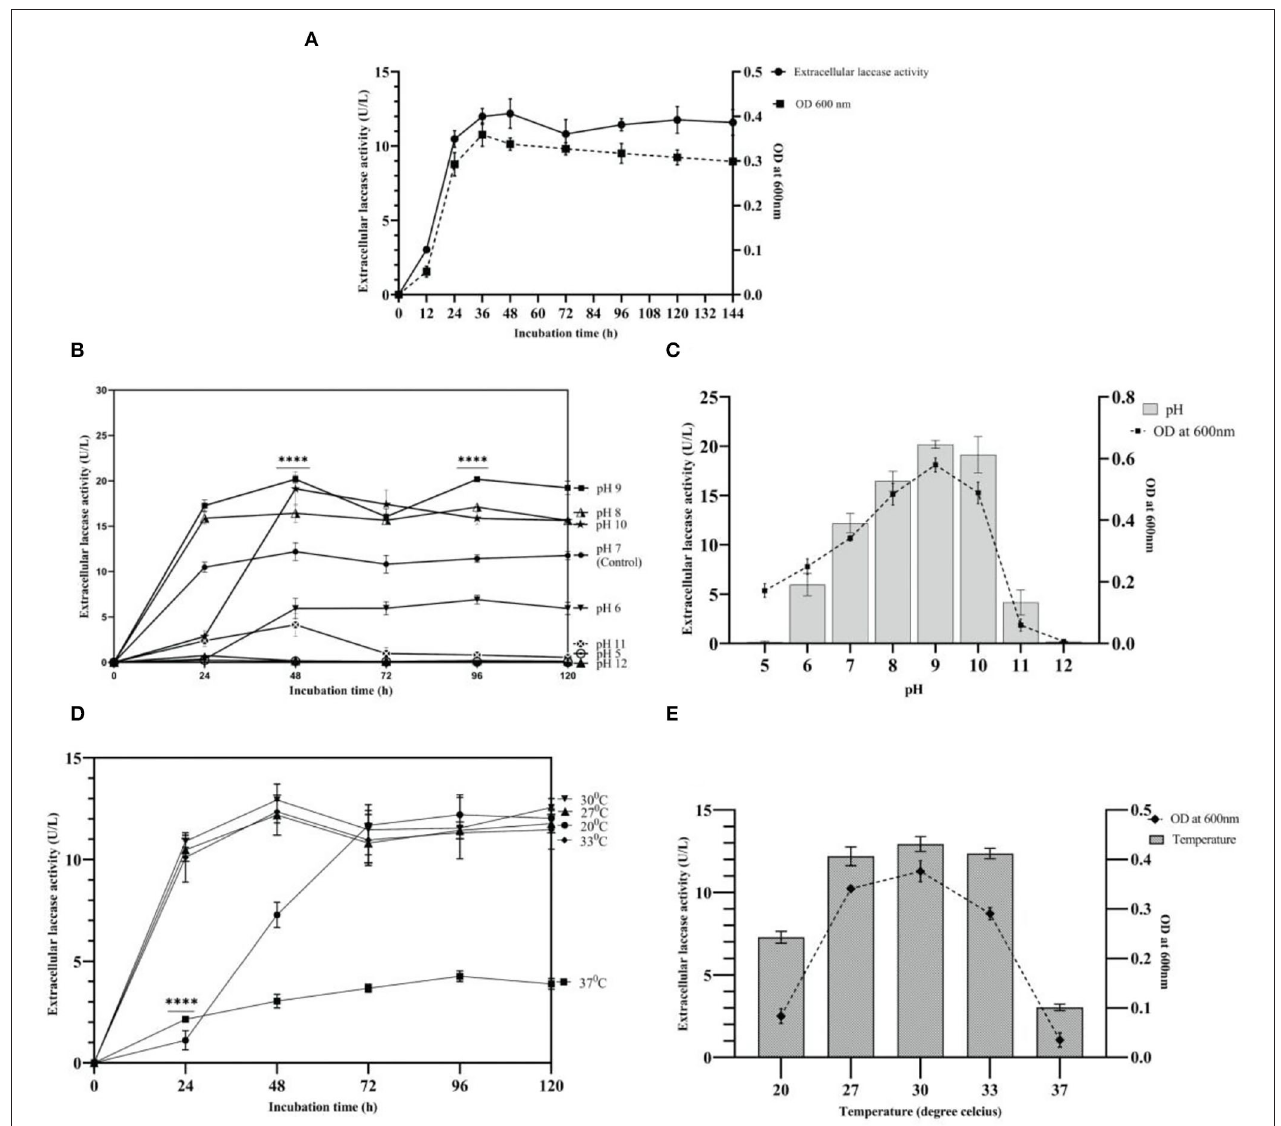
FIGURE 2 | (A) Growth and laccase activity profiles of strain AORB19. (B) Effect of initial pH values on laccase production; (C) Effect of pH on growth and laccase production at 48h; (D) Effect of temperature on laccase production; and (E) Effect of temperature on growth and laccase production at 48h. The four stars (****) denoted the statistical significance according to the Dunnett’s multiple comparison test at P <